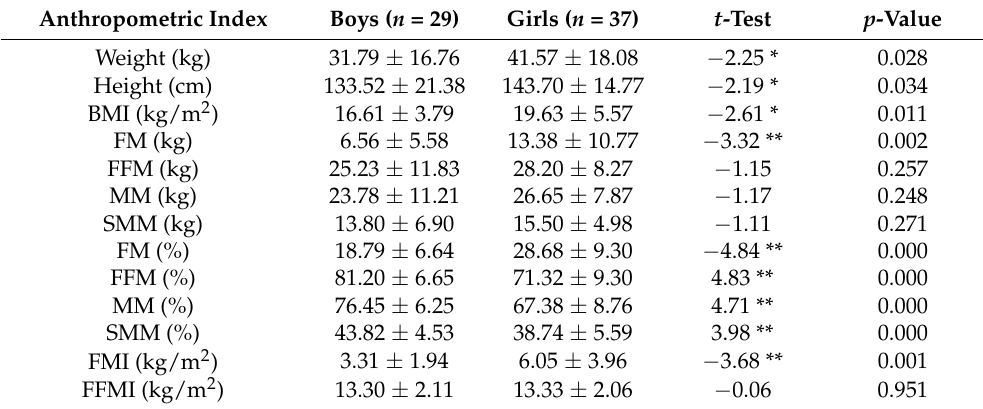
Table 4. Anthropometric measurements of the children ( n = 66) with CD following the Ministry of Health GFD program according to a body composition analyzer.